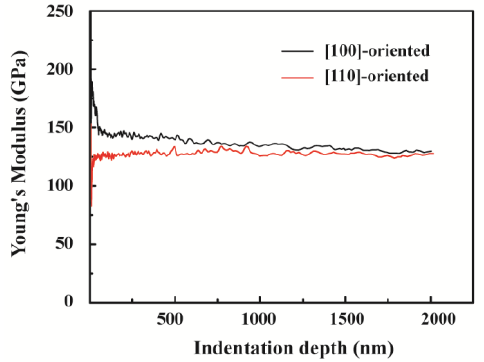
Figure 7. Hardness–indentation depth curves of the [100]- and [110]-oriented PIN–PMN–PT bulk single crystals.